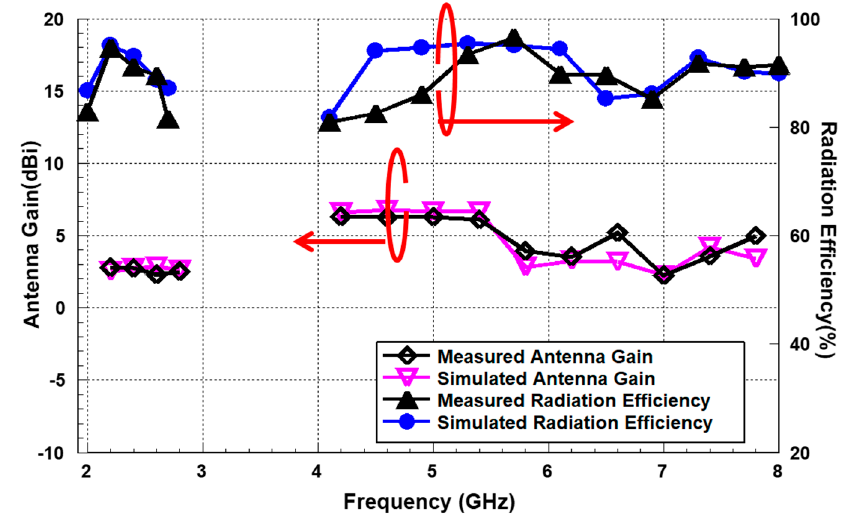
Figure 7. The results of peak gain and radiation efficiency.